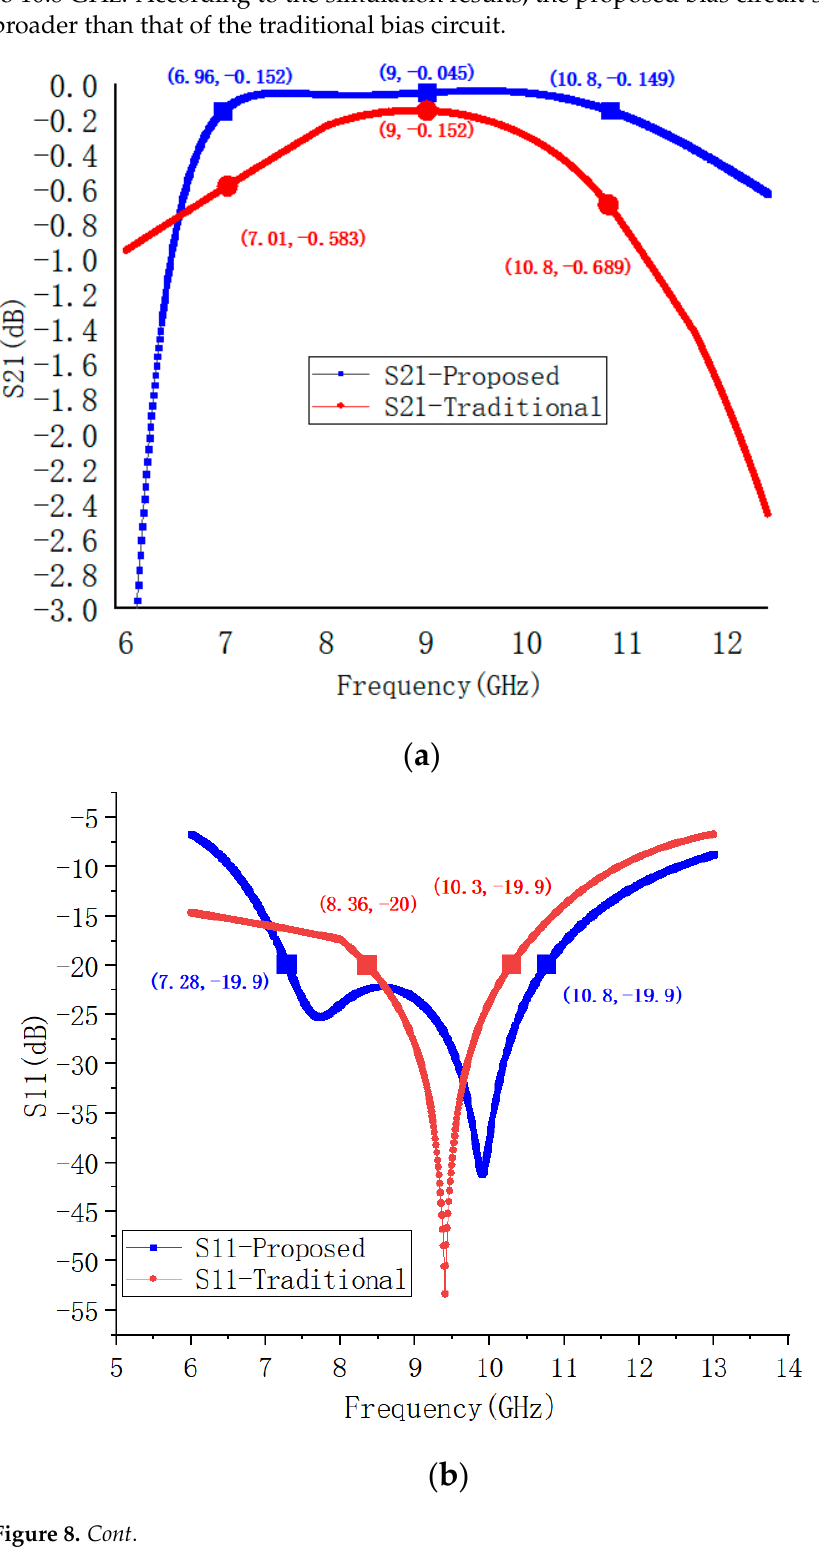
( c ) Figure 8. The results of the EM simulation for the S parameters of the proposed bias circuit and the traditional bias circuit. ( a ) S12. ( b ) S11. ( c ) S13. The parasitic inductance of the traditional bias circuit and the proposed bias circuit is simulated by ANSYS. The simulation ’ s structural diagram is presented in Figure 9. Be- sides the bias circuit, the soldering pad of the stability circuit, the solder, and the connect- ing line between the bias circuit and the modulated power-supply circuit are also included to make the simulation results as realistic as possible.